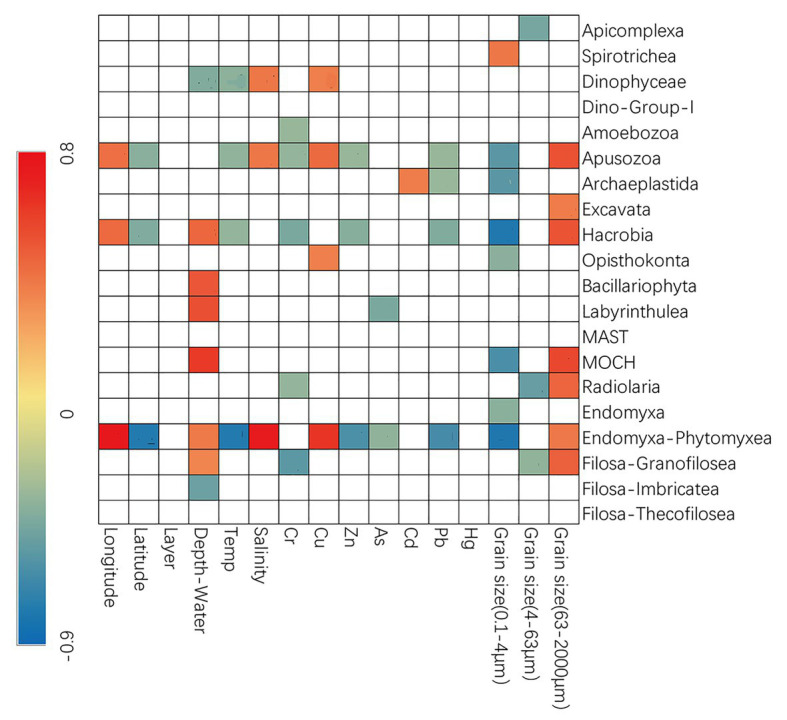
Spearman’s correlations between relative abundance and environmental parameters. The correlation coefficients’ values are indicated according to the color bar and insignificant values (p > 0.05) are left blank.